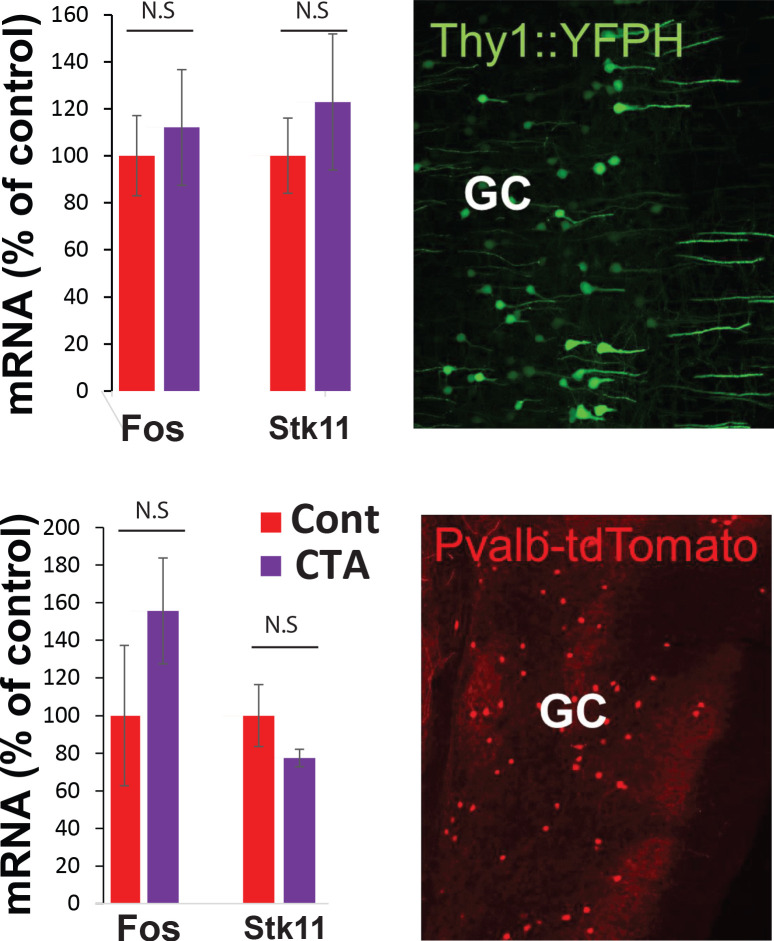
RNA sequencing from GC.Top. YFP-H L5 pyramidal neurons and Pvalb-tdTomato-positive interneurons in the GC. Fos and Stk11 did not differ significantly between CTA and taste control groups.